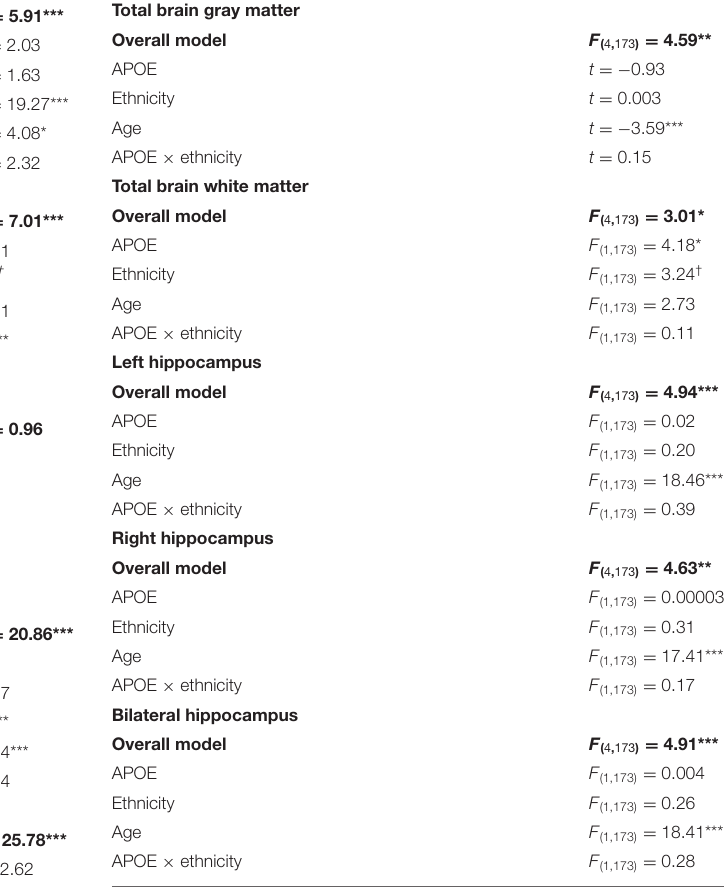
TABLE 2 | F -statistics for overall models (in bold) and exposure/covariate factors for models. Delayed verbal memory